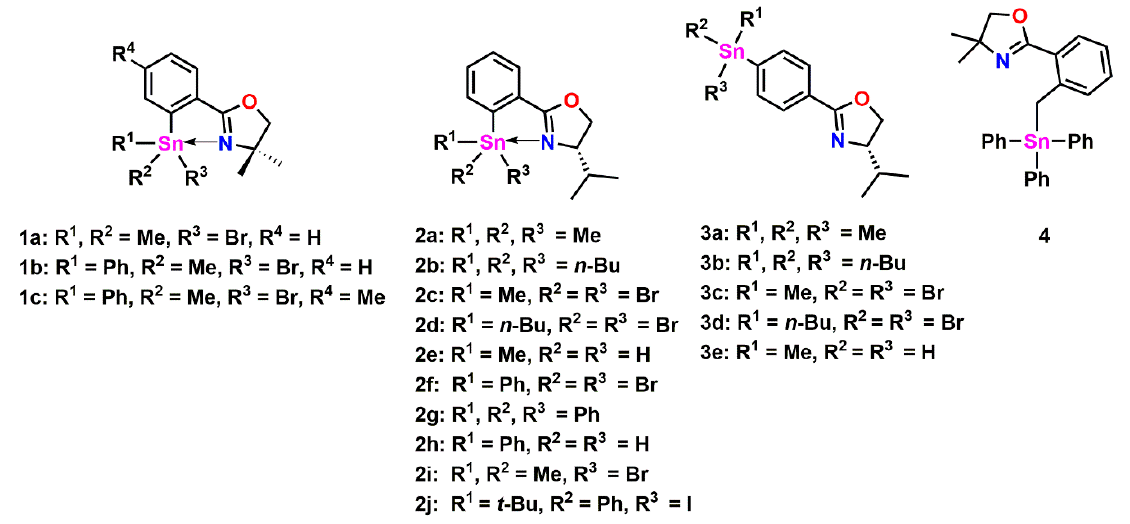
Figure 2. Structures of known tin oxazolines.